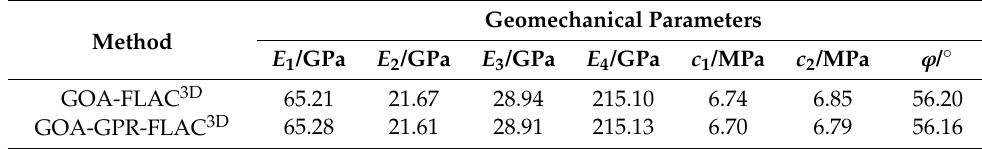
Table 5. Back-analysis results of geomechanical parameters by two methods.